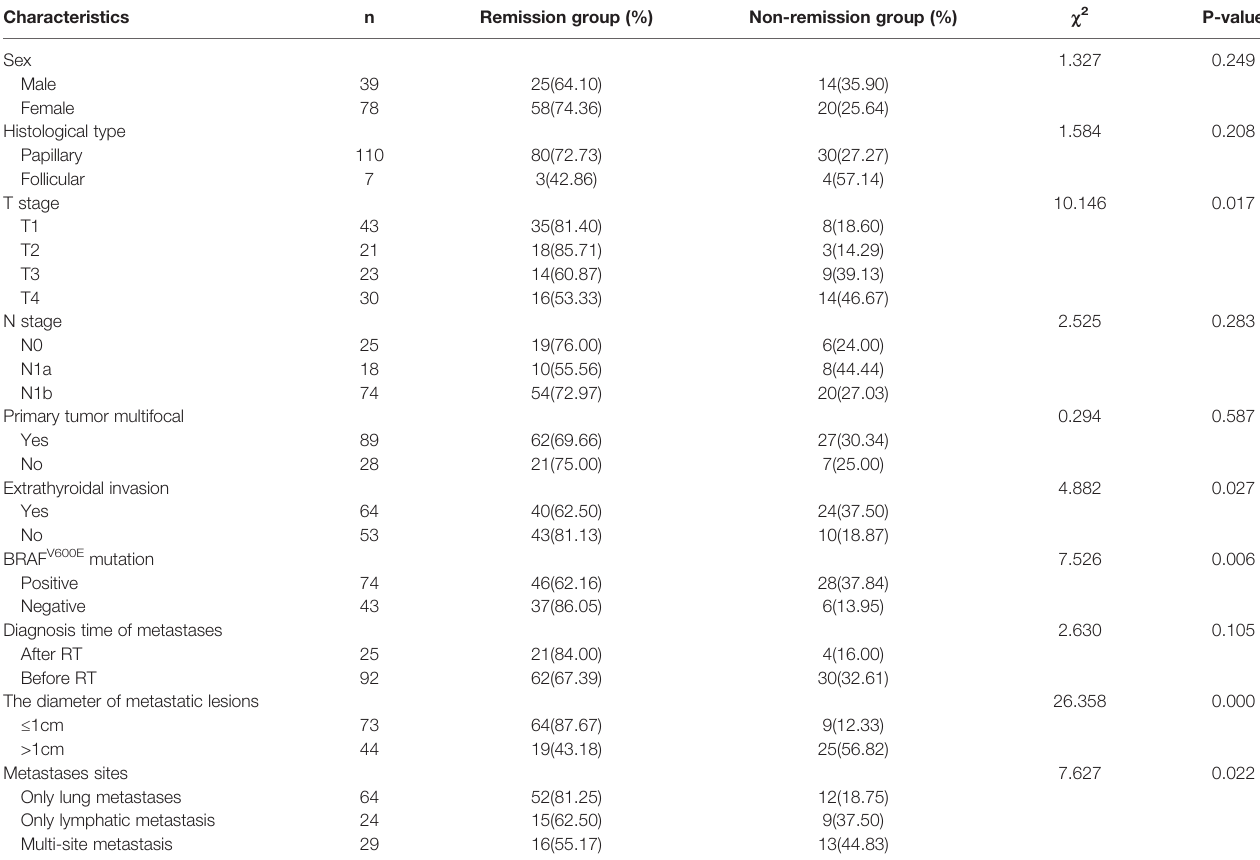
TABLE 3 | Univariate analyses for the categorical variables.